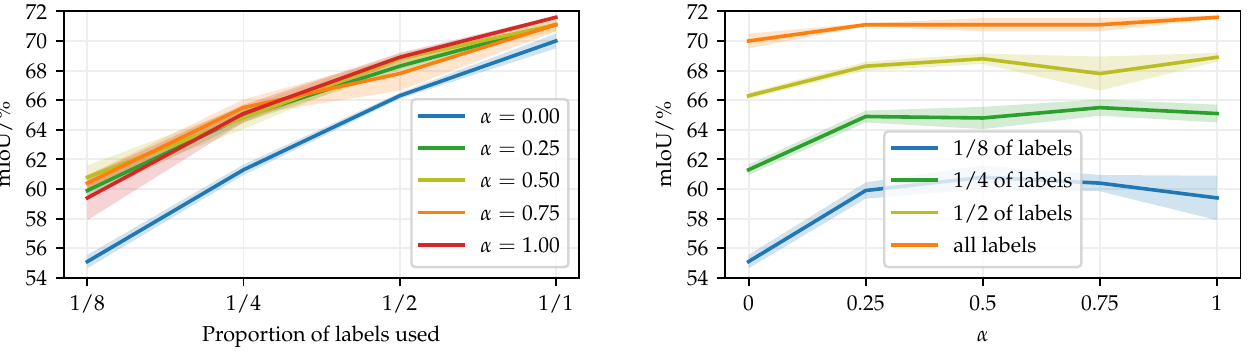
Figure 6. Validation of the consistency loss weight α on Cityscapes val (mIoU/%). We present the same results in two plots with different x-axes: the proportion of labels ( left ), and the consistency loss weight α ( right